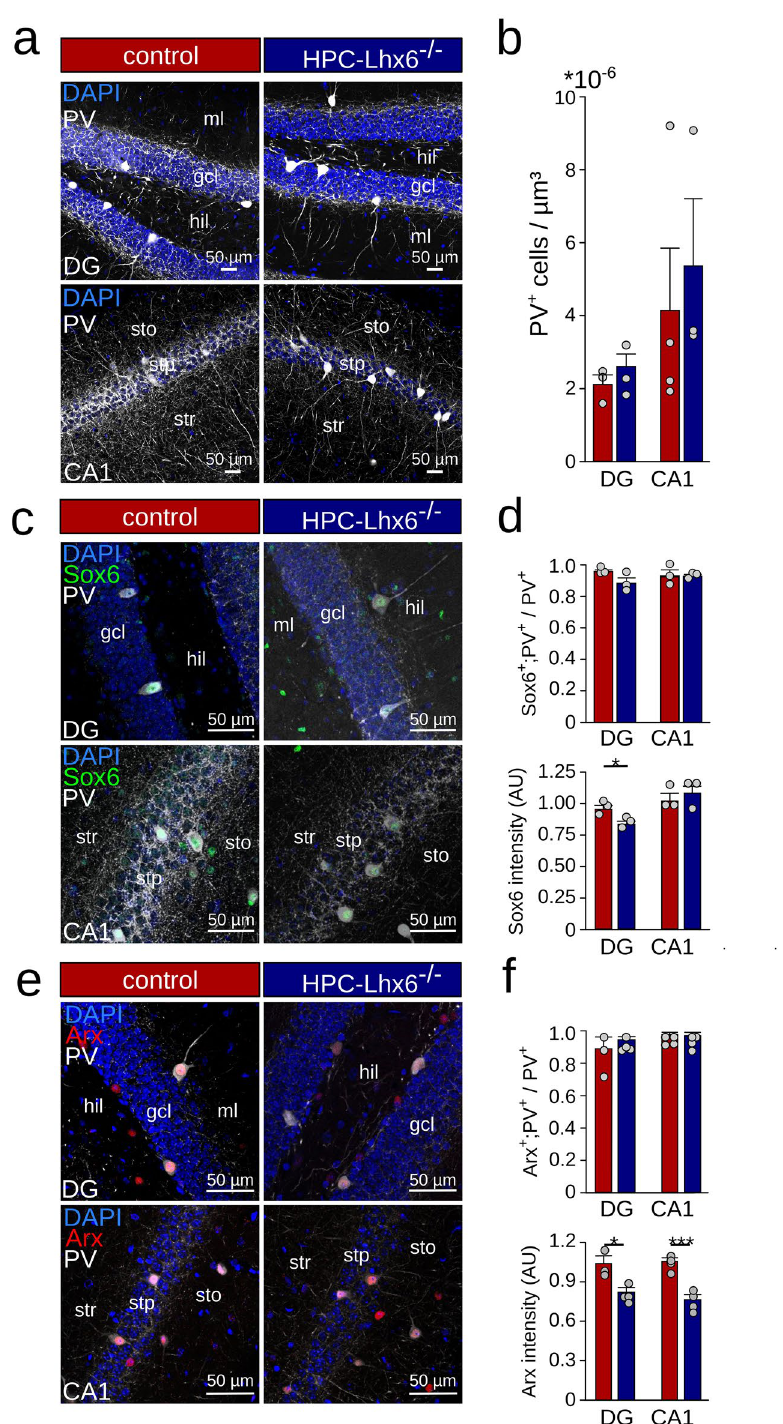
Figure 2. Intact downstream transcription factor expression upon removal of Lhx6 from PVIs. ( a ) Confocal image stacks of PV-staining (white) and DAPI (blue) in the dentate gyrus (DG, top) and CA1 (bottom) were used to quantify the number of PVIs in the hippocampus. Gcl granule cell layer, hil hilus, ml molecular layer, sto stratum oriens, stp stratum pyramidale, str stratum radiatum. ( b ) Quantification of the PVI density in control (red) and HPC-Lhx6 −/− (blue) mice revealed no significant difference between groups. ( c ) Confocal image stacks of PV (grey), Sox6 (green), and DAPI labelling (blue) in control and PV-Lhx6 −/− mice. ( d ) Quantification of the colabelling of Sox6 and PV revealed no difference in the number of colabelled neurons (top) but reduced expression levels in the DG of PV-Lhx6 −/− mice (bottom). ( e ) Same as ( c ) but with staining for the transcription factor Arx (red). ( f ) Quantification of the costaining of Arx and PV revealed no difference in the number of colabelled neurons (top) but reduced expression levels in PV-Lhx6 −/− mice (bottom). Data are mean ± sem. Data points show mouse averages. *p < 0.05, ***p <